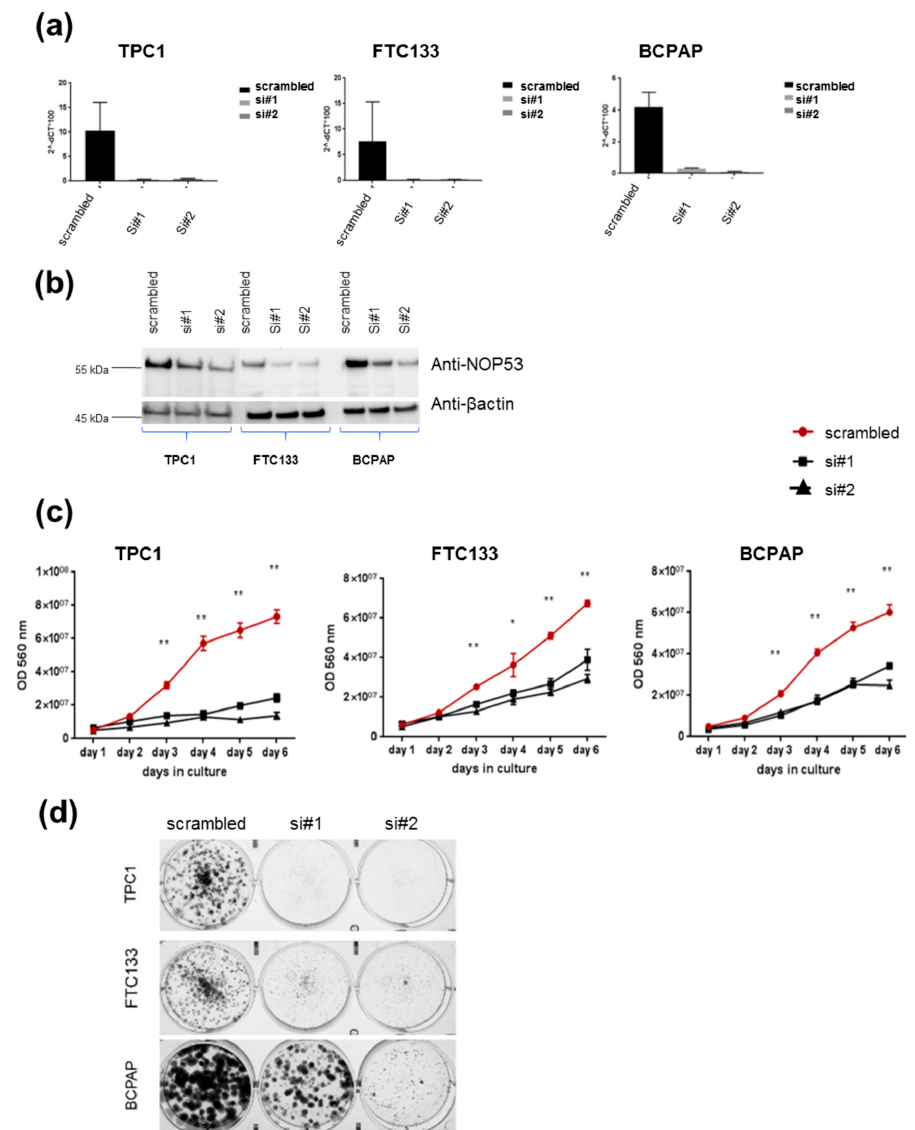
Figure 4. Knockdown of wild-type NOP53 reduces cell proliferation and clonogenicity: ( a ) Validation of two di ff erent siRNAs (si#1 and si#2) targeting NOP53 gene expression in three di ff erent thyroid cancer cell lines (TPC1, FTC133 and BCPAP) using qPCR; ( b ) Validation of two di ff erent siRNAs (si#1 and si#2) targeting NOP53 protein expression in three di ff erent thyroid cancer cell lines (TPC1, FTC133 and BCPAP) using Western blots. The total protein lysates used were 25 µ g for TPC1 cell line; and 30 µ g for FTC133 and BCPAP cell lines. GAPDH and β -actin were used as an internal and loading control for qPCR and Western blot, respectively; ( c ) Transient knockdown of NOP53 in three di ff erent cell lines with two siRNAs significantly reduced cell proliferation compared to negative control (scrambled), suggesting a proto-oncogenic function of NOP53 ; ( d ) Transient knockdown of NOP53 in three di ff erent cell lines with two siRNAs significantly reduced cell clonogenicity compared to negative control (scrambled), suggesting a proto-oncogenic function of NOP53 . * indicates adjusted p value < 0.05 compared to control. ** indicate adjusted p value < 0.01 compared to control. Error bars indicate standard